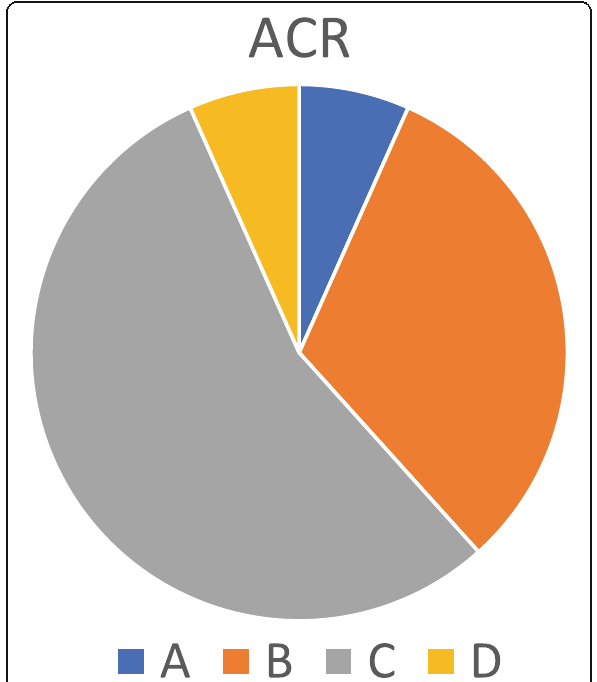
Fig. 1 Distribution of cases according to the ACR BIRADS lexicon breast density classification